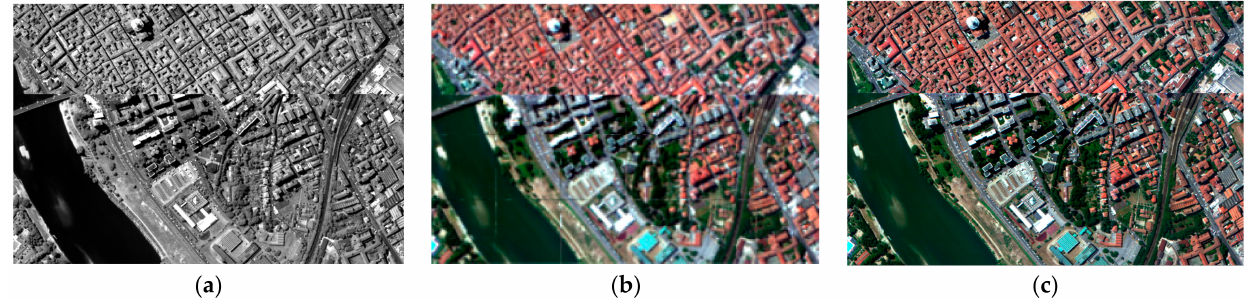
Figure 6. The Pavia Center dataset: ( a ) Panchromatic image, ( b ) RGB image of hyperspectral data and ( c ) RGB image of ground truth data.